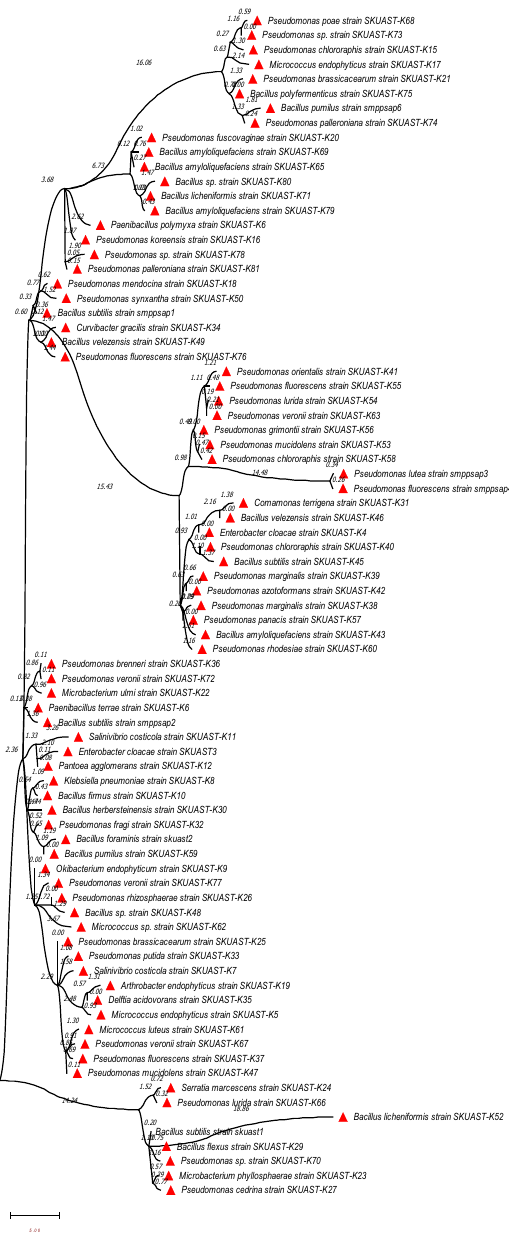
Figure 2. The evolutionary history was anecdotal via the Neighbor-Joining method. The ideal tree with the sum of branch length = 26.06144331 is shown. The bootstrap consensus tree anecdotal from 1000 replicates is kept to and divisions consistent to partitions replicated in less than 50 per cent bootstrap replicates are warped. The evolutionary detachments were computed by means of the p-distance method and are in the units of the number of base variances per site. The confidence likelihood that the interior branch length is larger than 0, as projected using the bootstrap test (revealed next to the kindling). This analysis involved 81 nucleotide sequences. Codon sites encompassed were 1st + 2nd + 3rd + Noncoding. All sites with fewer than 95% site coverage were rejected, i.e., ambiguous bases were allowed at any position (partial deletion option), missing data and fewer than 5% alignment gaps. There were a total of 1427 positions in the final dataset. Evolutionary studies were conducted in MEGA X (v